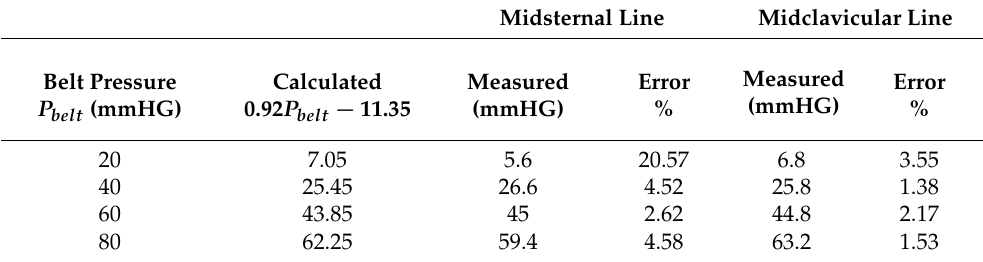
Table 1. The average pressure values [mmHG] measured along the midsternal and midclavicular lines compared with the empirical formula